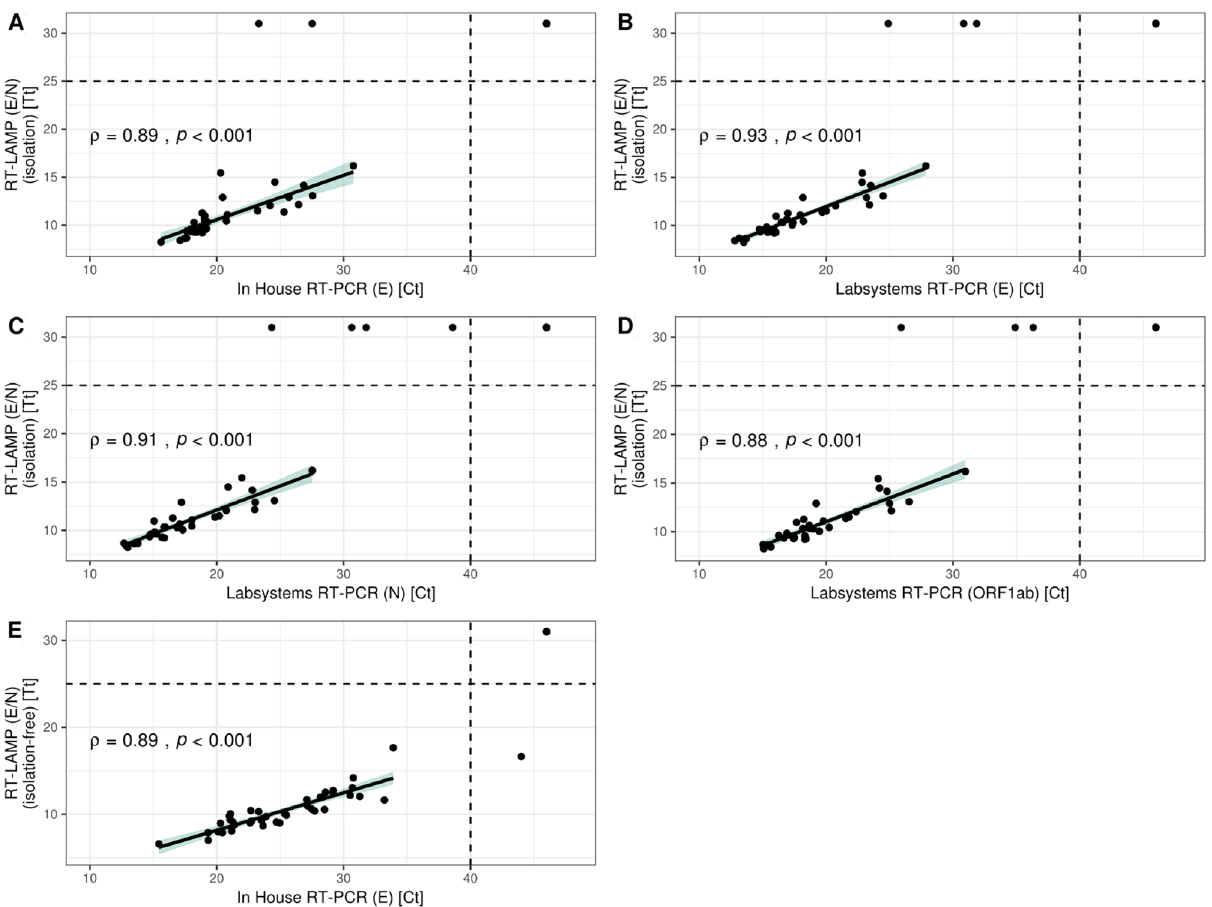
Figure 2. Comparison of the SARS-CoV-2 RT-LAMP Tt values and the RT-PCR Ct values. The dashed lines represent the negative cut-offs. Artificial Ct and Tt values above these cut-offs were assigned to negative samples for data visualization purpose. Spearman correlation results are shown. Only true positive samples were included into the correlation analysis. ( A ) SARS-CoV-2 RT-LAMP with RNA isolation compared to the in-house RT-PCR. ( B ) SARS-CoV-2 RT-LAMP with RNA isolation compared to the LabsystemsDx RT-PCR (E gene target). ( C ) SARS-CoV-2 RT-LAMP with RNA isolation compared to the LabsystemsDx RT-PCR (N gene